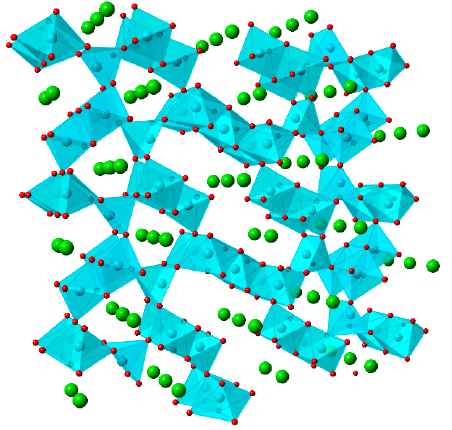
Figure 6. Schematic illustration of the crystal structure of Na 2 Mn 5 O 10 . This structure consists of purple octahedral units MnO 6 shared by corners and/or edges, where Na + occupies positions within channels formed by octahedrals units (JCPDS 27-0749).